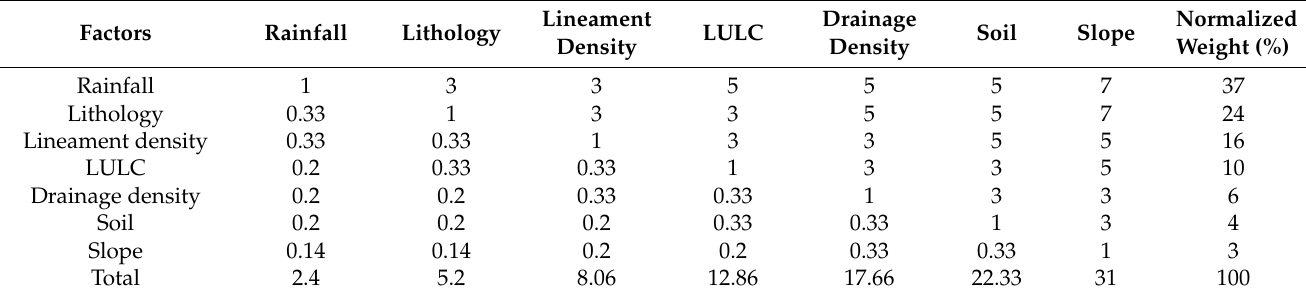
Table 2. Pair-wise comparison matrix of seven thematic layers and their normalised weights.